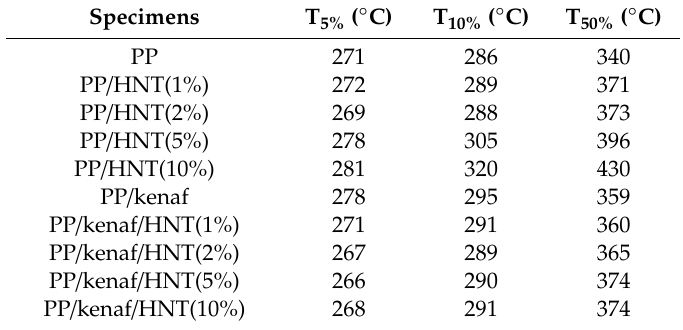
Table 4. Characteristic temperatures of the thermo-oxidative decomposition of the